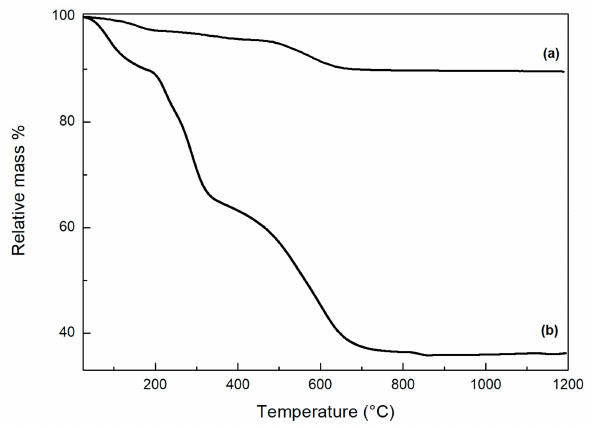
Figure 3. Thermal analysis (TGA) of α -ZrP ( a ) and ZrP-GTM intercalation compound ( b